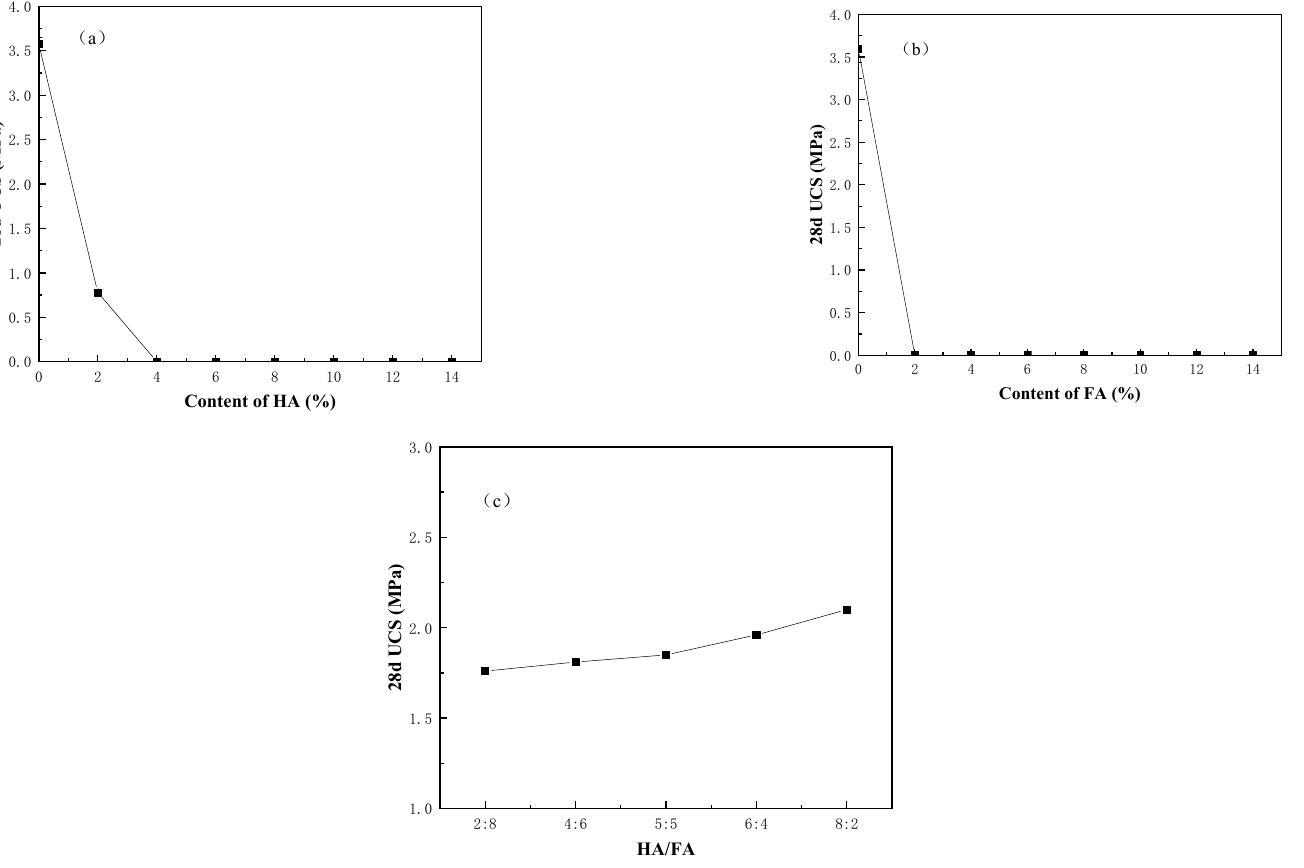
Figure 3. ( a ) Effect of humic acid on UCS; ( b ) Effect of fulvic acid on UCS; and ( c ) Effect of different HA/FA ratios on UCS.